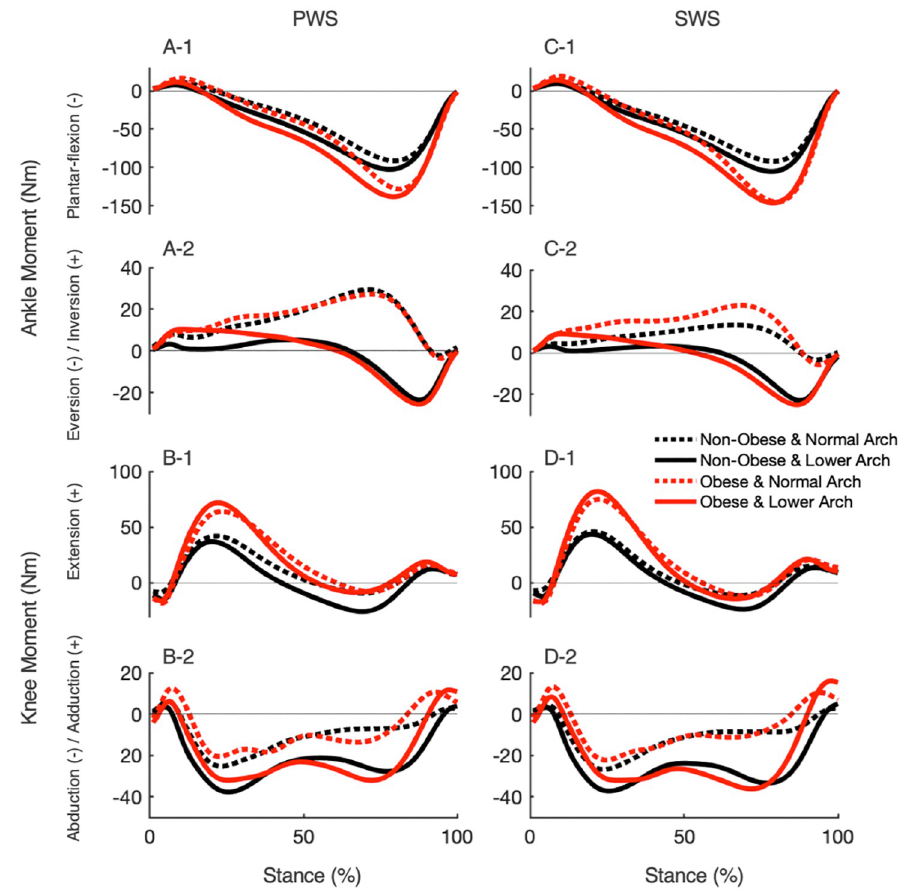
Fig 2. Group mean ankle and knee joint moments for the right leg. We plotted the internal ankle plantar-flexion moment (A-1, C-1), internal ankle eversion moment (A-2, C-2), internal knee extension moment (B-1, D-1), and internal knee abduction moment (B-2, D-2) over the stance phase of walking at preferred walking speed (PWS, A-B) and pedestrian standard walking speed, 1.25 m/s (SWS, C-D). Black lines represent the non-obese group, while red lines represent the obese group. Dashed lines represent the normal arch group, while solid lines represent the lower arch group. greater in individuals with obesity compared to individuals with normal weight at both pre- ferred and standard walking speeds ( p < 0.01). For kinetic measures at the ankle and knee joints, as shown in Fig 2 and Table 4, there were statistically significant main effects of BMI on peak internal ankle plantar-flexion moment and peak internal knee extension moment, F (1,43) = 28.55, p < 0.01, η p 2 = 0.40 and F (1,43) = 18.76, p < 0.01, η p 2 = 0.30, respectively. There were also significant effects of speed on the peak internal ankle plantar-flexion moment and the peak internal knee extension moment, F (1,43) = 17.23, p < 0.01, η p 2 = 0.29 and F (1,43) = 20.37, p < 0.01, η p 2 = 0.32, respectively. Peak internal ankle plantar-flexion and knee extension moments were less at the preferred walking speed than the standard walking speed ( p < 0.01). Individuals with obesity had greater peak internal ankle plantar-flexion and knee extension moments than individuals with normal weight ( p < 0.01). There were significant main effects of arch height on the peak internal ankle eversion moment, F (1,43) = 132.09, p < 0.01, η p 2 = 0.75) and abduction moment, F (1,43) = 9.38, p < 0.01, η p 2 = 0.18, and the first peak internal knee abduction moment, F (1,43) = 19.98, p < 0.01, η p 2 = 0.32 (Fig 2 and Table 4). Peak internal